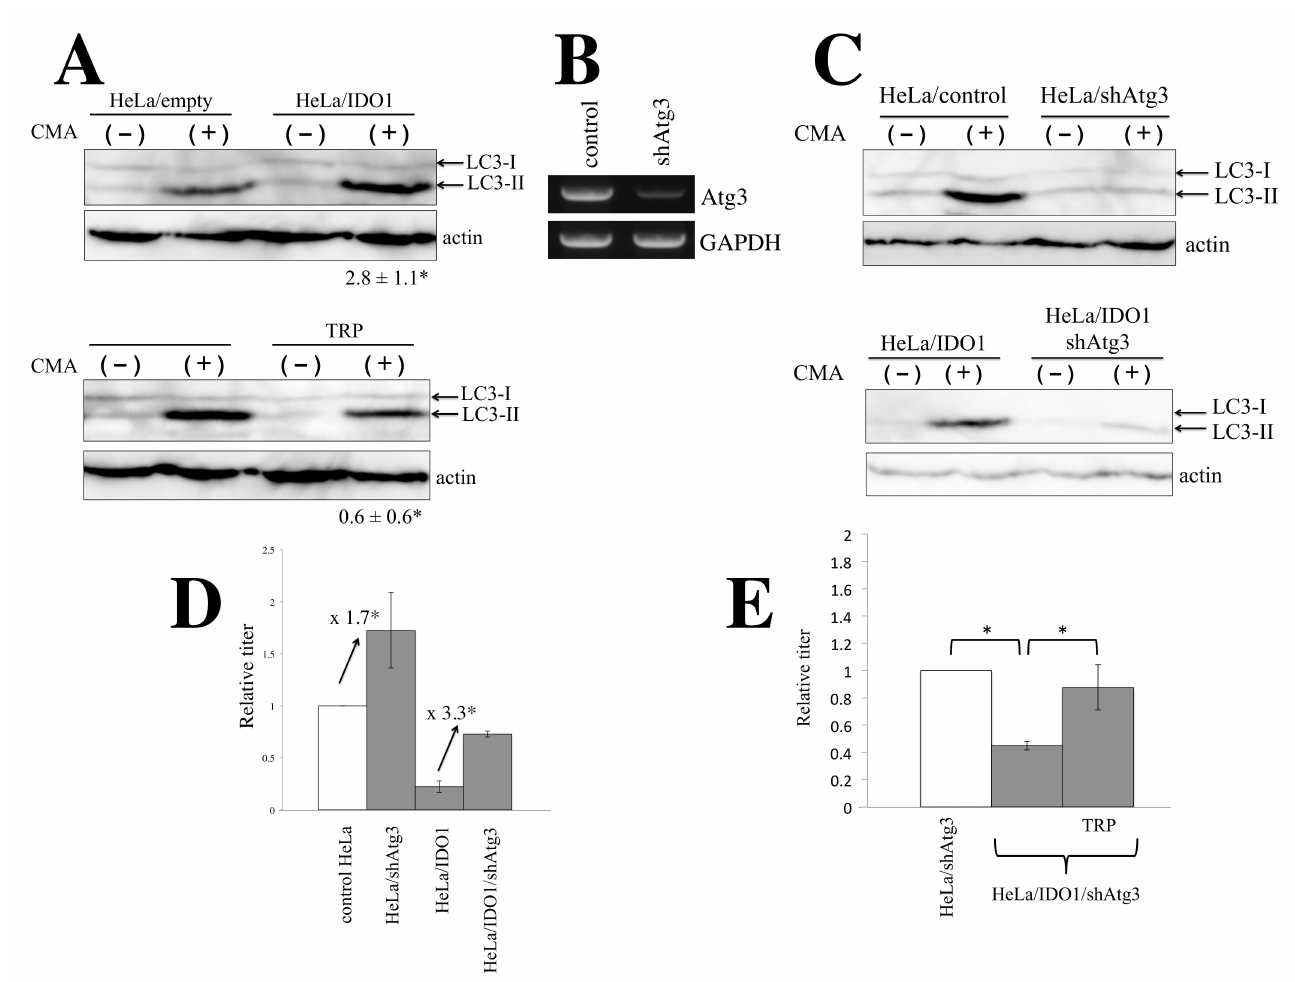
Figure 5. IDO1 inhibits HIV-1-based vector infection through autophagy. ( A ) HeLa/empty or HeLa/IDO1 cells were treated with or without CMA, and cell lysates were prepared. The cell lysates were analyzed by Western blotting using anti-LC3 antibody. Rations of LC3-II to LC3-I were measured. The ratios in CMA-treated control HeLa cells were always set to 1, and relative values ± SD are indicated. Asterisks indicate significant differences compared to CMA-treated HeLa/empty cells. This experiment was performed in triplicate. ( B ) Total RNA samples were prepared from HeLa/control and HeLa/shAtg3 cells. Atg3 mRNA level was measured by semi-quantitative RT- PCR. ( C ) Control and HeLa/IDO1, HeLa/shAtg3, and HeLa/IDO1/shAtg3 cells were treated with or without CMA, and cell lysates were prepared. The cell lysates were analyzed by Western blotting using anti-LC3 antobody. ( D ) Amphotropic MLV-pseudotyped HIV-1-based vector was inoculated to the indicated cells. Transduction titers in control HeLa cells are always set to 1, and relative values ± SD are indicated. Asterisks indicate significant differences between the indicated groups. This experiment was performed in triplicate. ( E ) Amphotropic MLV-pseudotyped HIV-1-based vector was inoculated into indicated cells in the absence of tryptophan. The inoculated cells were cultured for 6 days in the presence of tryptophan and further cultured for 3 days with or without tryptophan. The cells were stained with X-Gal. Numbers of blue cells in HeLa/shAtg3 cells cultured without tryptophan were always set to 1, and relative values ± SD were indicated. Asterisks indicate significant differences between the indicated groups. This experiment was performed in